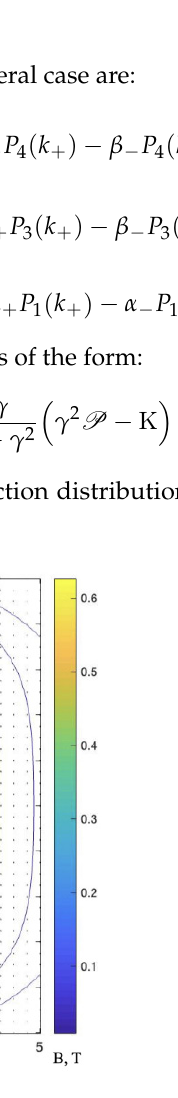
Figure 3. Magnetic induction configuration around ferromagnetic cylinder magnetised along the diameter. The parameters are the same as in Figure 2. Colour scale shows the magnitude of |𝐵| in 𝑇 .